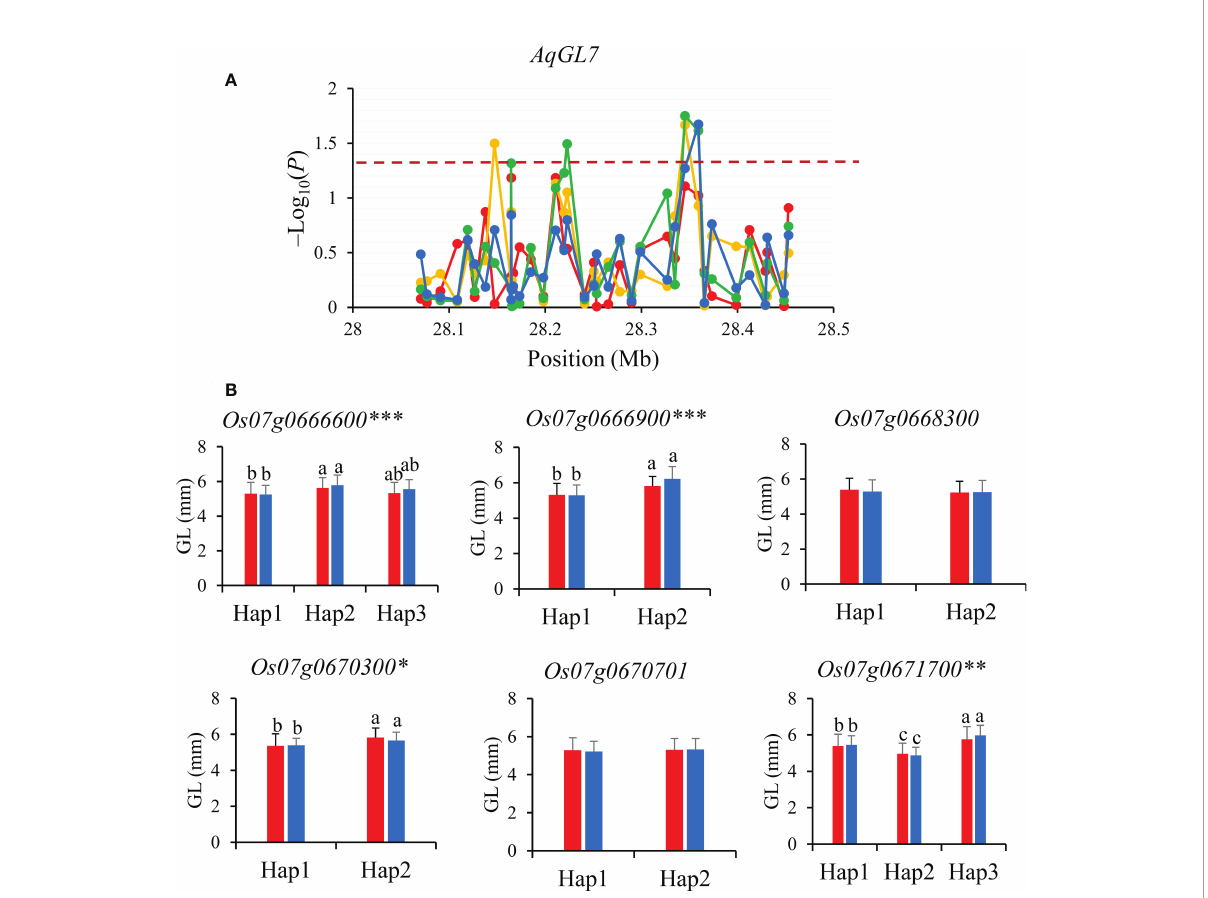
FIGURE 5 Gene-based association analysis (A) and haplotypes analysis of candidate genes (B) of AqGL7 . Dash line showed the threshold to determine signi fi cant SNP. The *, ** and *** suggested signi fi cance of ANOVA at p < 0.05, p < 0.01 and p < 0.001, respectively. The letter on histogram (a, b and c) indicated multiple comparisons result at the signi fi cant level 0.05. Red, orange, green and blue color of lines indicated 15_PX, 16_PX, 15_SZ and 16_SZ environments, respectively. The red and blue color of the histogram indicated SY and SZ in 2015,